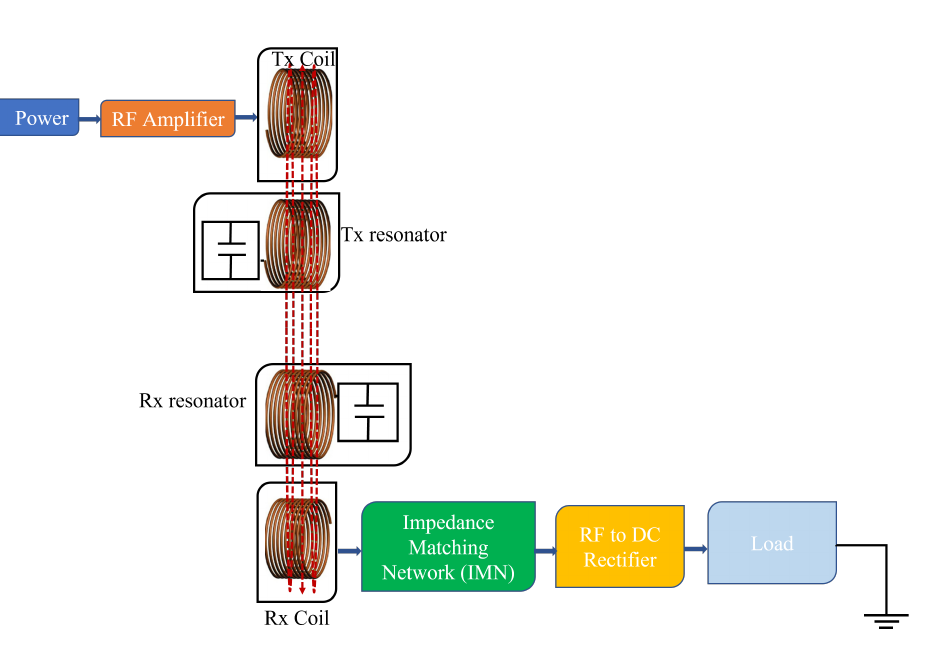
Figure 8. Strongly coupled magnetic resonance for WPT